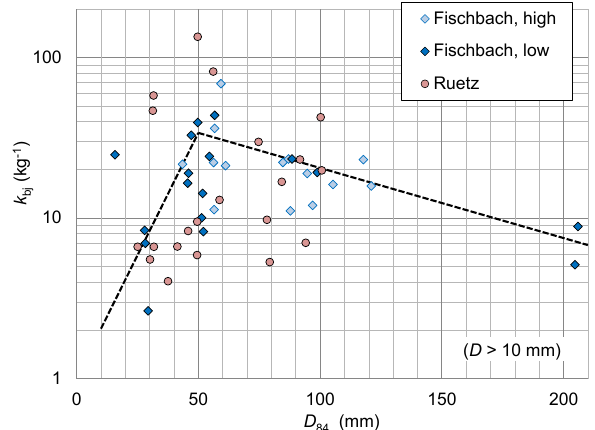
Figure 5. Fischbach: geophone calibration relationships for grains with D > 10mm between bedload mass M and number of impulses IMP. The linear and power law regression equations are based on 31 calibration measurements for the years 2008–2013.